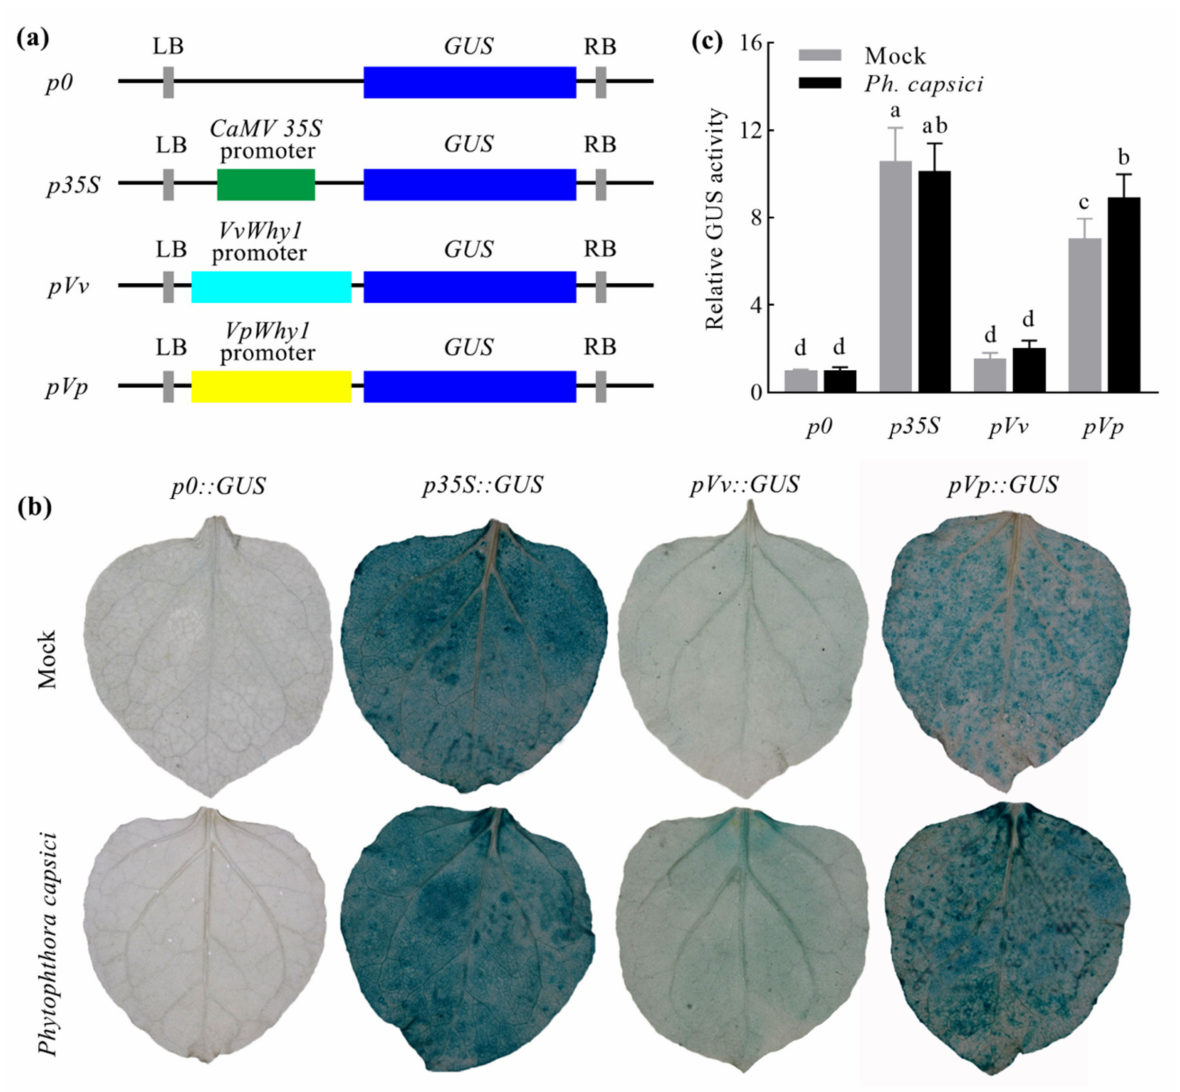
Figure 5. Construction of plant expression vectors and analysis of promoter activity. ( a ) Schematic representation of Why1 promoter-GUS constructs. p0 and p35S refer to negative and positive controls, respectively. ( b ) Histochemical staining analysis of GUS activity in transiently transformed N. ben- thamiana leaves. P. capsici treatments were prepared with zoospores (100 zoospores/ µ L), while mock treatments were sprayed with sterile water. ( c ) Relative quantitative GUS activity of fluorometric analysis. Tukey’s multiple comparisons test was conducted by using GraphPad Prism 8.0. Vertical bars represent standard deviations; different letters indicate significant differences at the 0.05